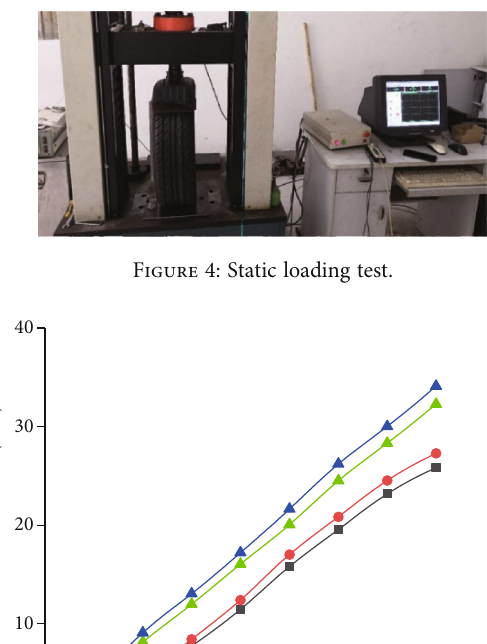
Figure 2: Fluid domain model and meshing.